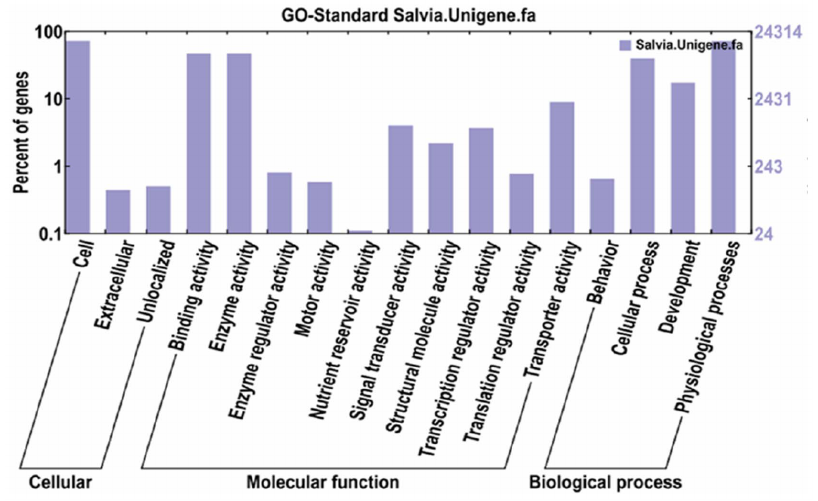
Figure 2. GO annotation.